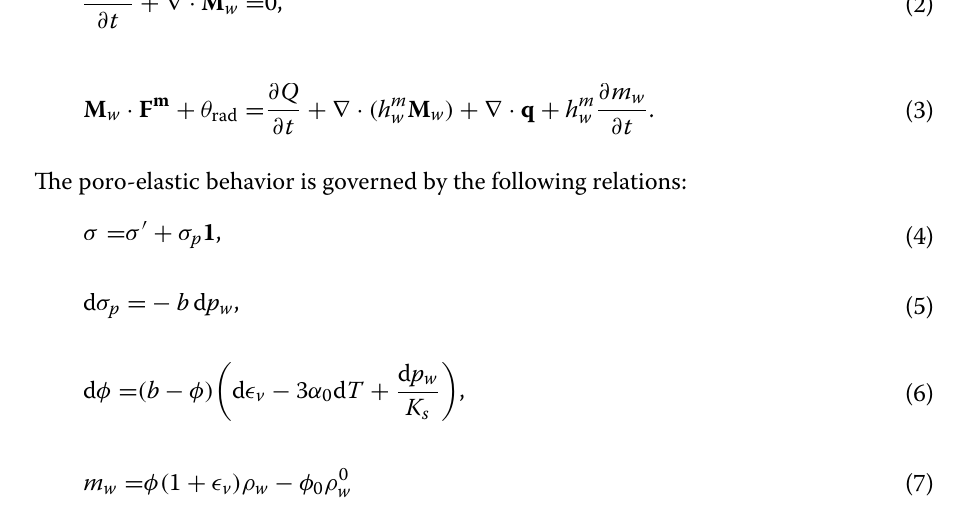
− 3 ] and φ 0 the initial porosity. The thermody-